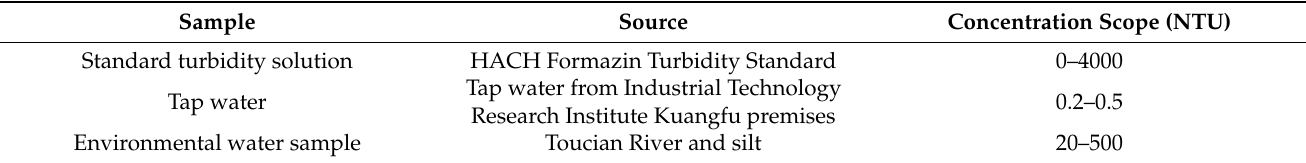
Table 2. Sample sources and basic concentrations.